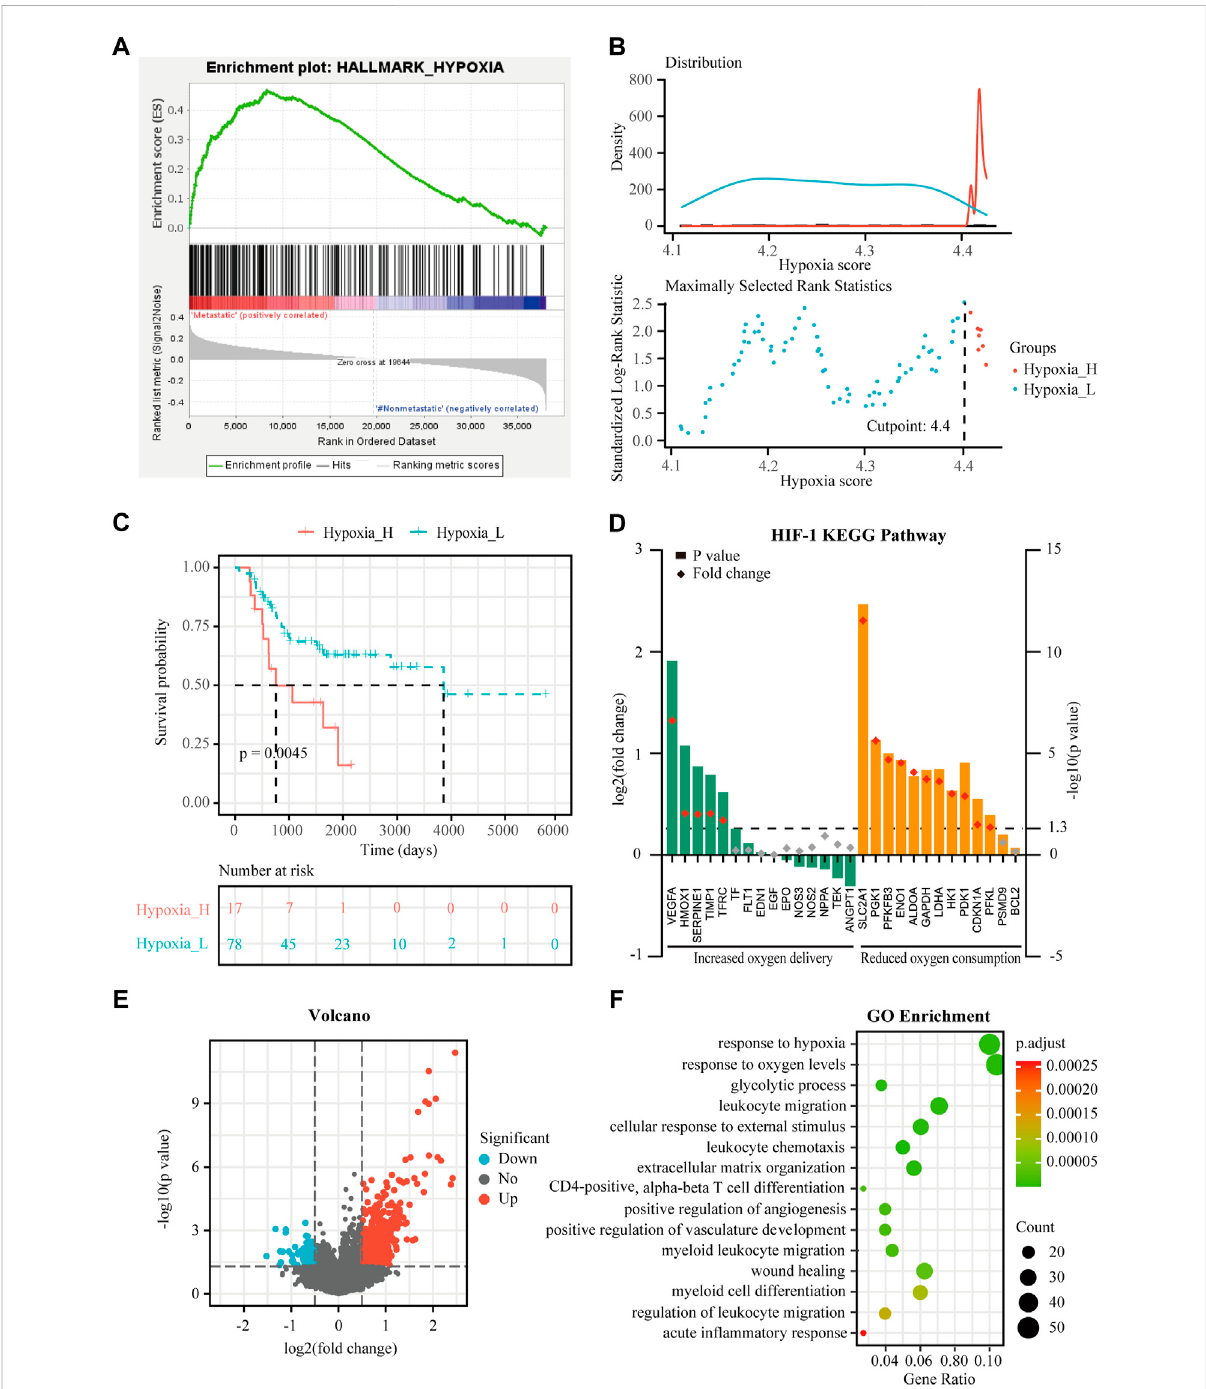
FIGURE 1 Identi fi cation of hypoxia status and hypoxia-related differentially expressed genes (DEGs) in osteosarcoma. (A) Gene Set Enrichment Analysis (GSEA) of hypoxia between metastatic and non-metastatic osteosarcoma in the TARGET dataset. (B) Histogram of the density distribution of the hypoxia score for hypoxia-high and hypoxia-low groups divided by the optimal cutoff. Scatter plot of the standardized log-rank statistic value for eachcorrespondinghypoxiascorecutoff. (C) Kaplan-Meier(K-M)plotofoverallsurvivalforpatientsinhypoxia-highandhypoxia-lowgroupsin the TARGET dataset. (D) Expression changes (hypoxia-high versus hypoxia-low) of target genes involved in HIF-1 KEGG pathway in the TARGET dataset. (E) Volcano plot showing the DEGs between hypoxia-high and hypoxia-low groups in the TARGET dataset. (F) Gene Ontology (GO) analysis of DEGs between hypoxia-high and hypoxia-low groups in the TARGET